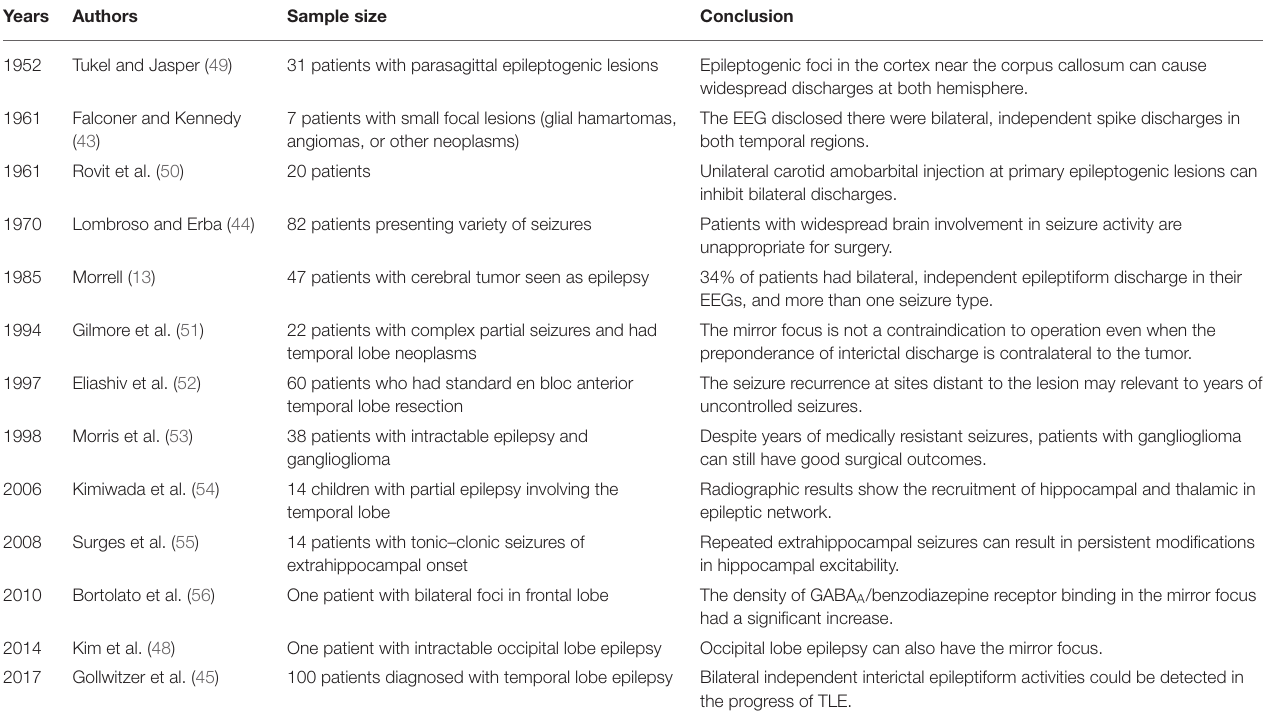
TABLE 2 | Secondary epileptogenesis in